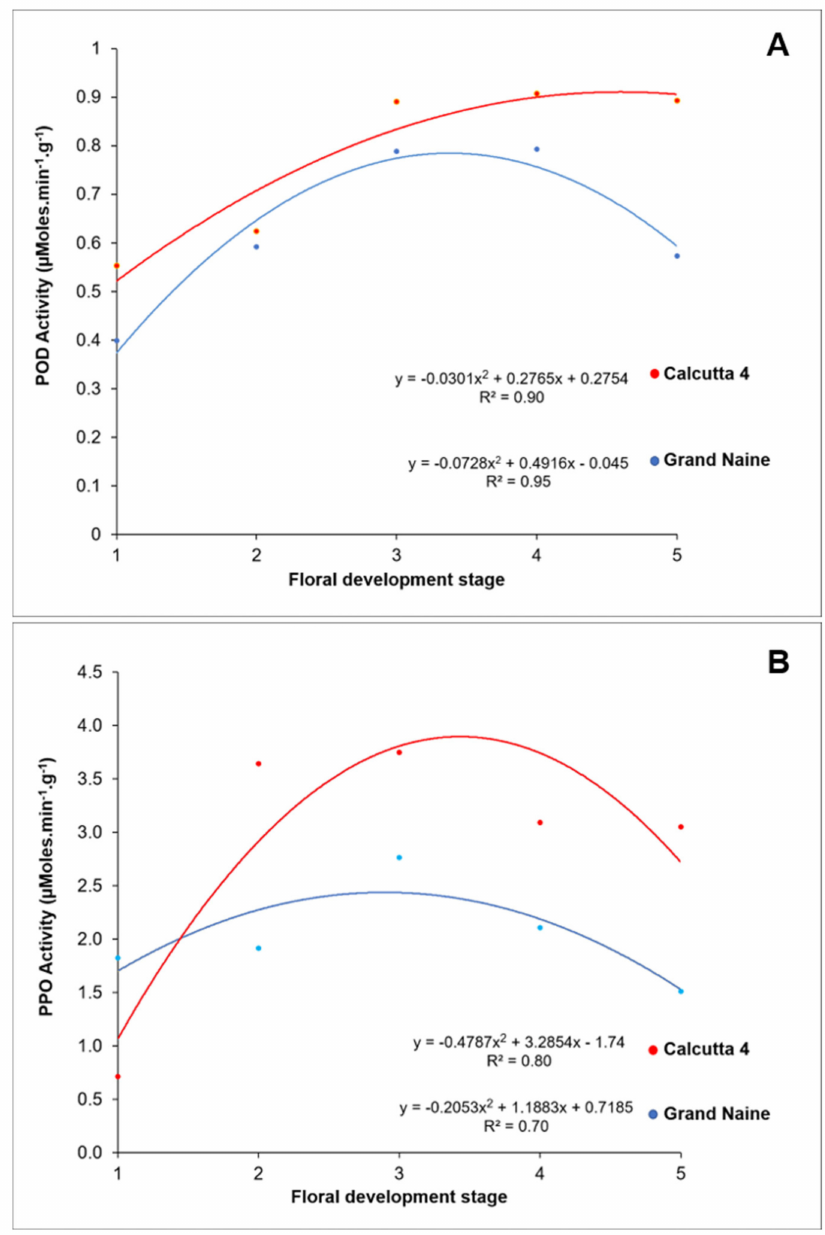
Figure 3. Specific activity of peroxidase (POD) ( A ) and polyphenol oxidase (PPO) ( B ) at different stages of floral development in Calcutta 4 and Grand